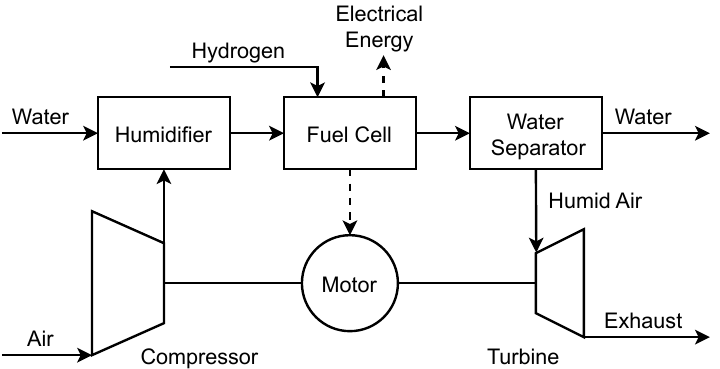
Figure 1. Electrically turbocharged air-management system for a proton exchange membrane fuel cell (PEMFC). Adapted from [12]. Copyright 2022